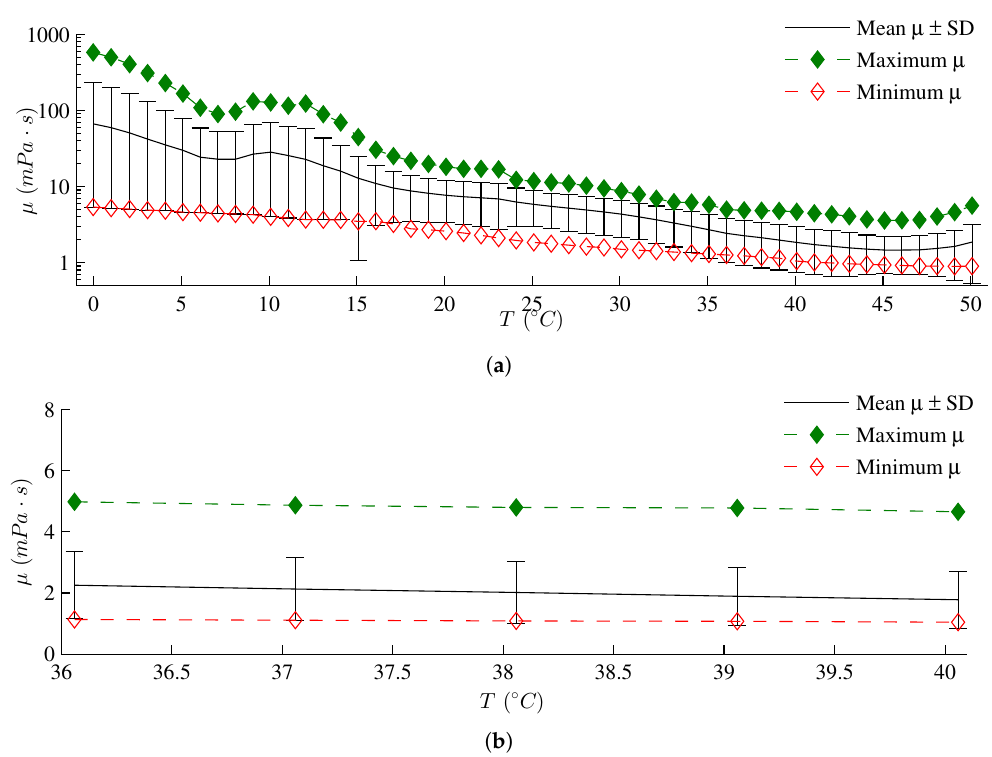
Figure 6. Human milk viscosity response to temperature at 50 s − 1 . Human milk viscosity generally decreased as temperature increased. The highest (maximum) and lowest (minimum) viscosity values are presented to show the range of recorded data with maximum viscosity falling outside the expected value range of SD. ( a ) Unexpected increases in mean and maximum viscosity began at 8 ◦ C and 46 ◦ C. ( b ) While temperature decreased viscosity over normal reheating temperature ranges, the decrease was minimal.